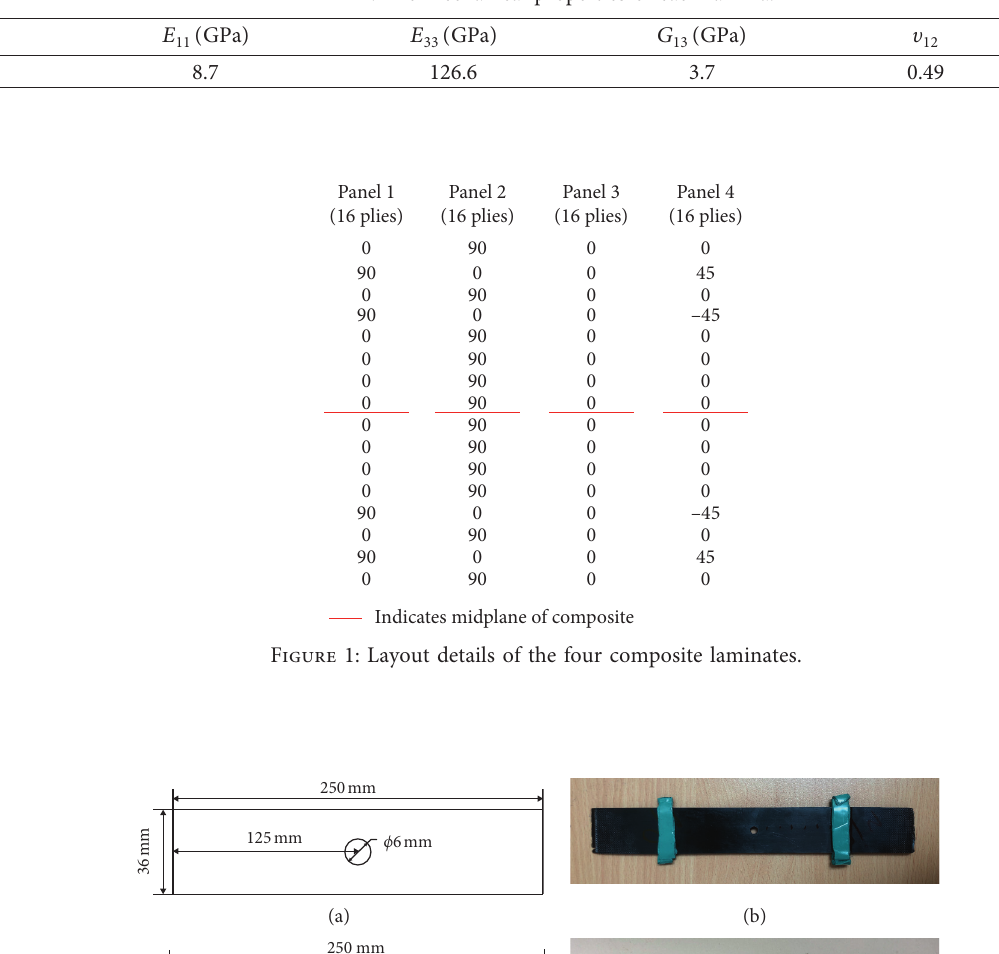
Table 1: The mechanical properties of each lamina.